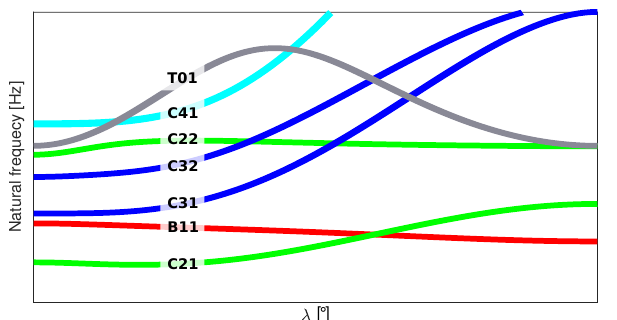
Figure 1. An example of natural frequencies crossing; three-layer composite cylinder with stacking sequence [ λ ,0, λ ]